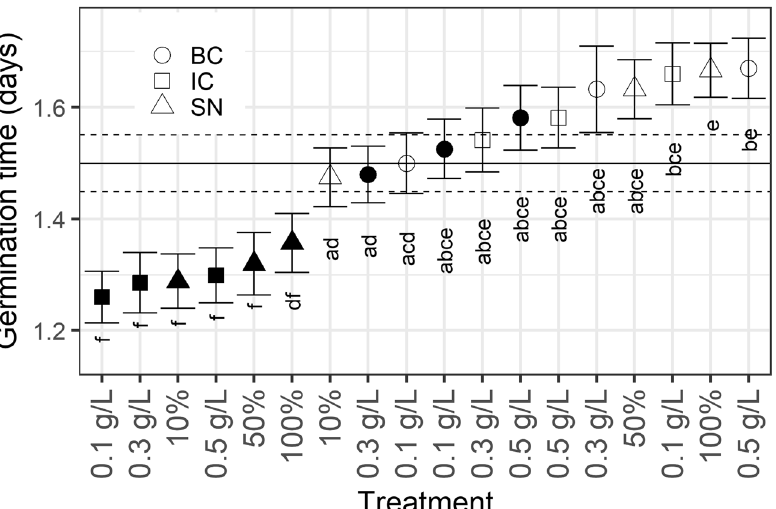
Figure 4. Germination times (in days) of barley seeds. Shapes indicate the mean of the 100 seeds for each treatment, filled shapes indicate C. vulgaris (13–1), open shapes indicate S. obliquus (B2–2). IC squares, BC circles, SN triangles. Letters below shapes indicate group belonging, within which no significant difference at the 0.05 level could be found (Kruskal–Wallis rank sum test with Conover’s post hoc test). Mean of the control group is indicated by the horizontal line, and its group adherence is “abcd”. Error bars indicate ± s.e.m. (in the case of the control value indicator, ± s.e.m. is indicated by dashed horizontal lines).